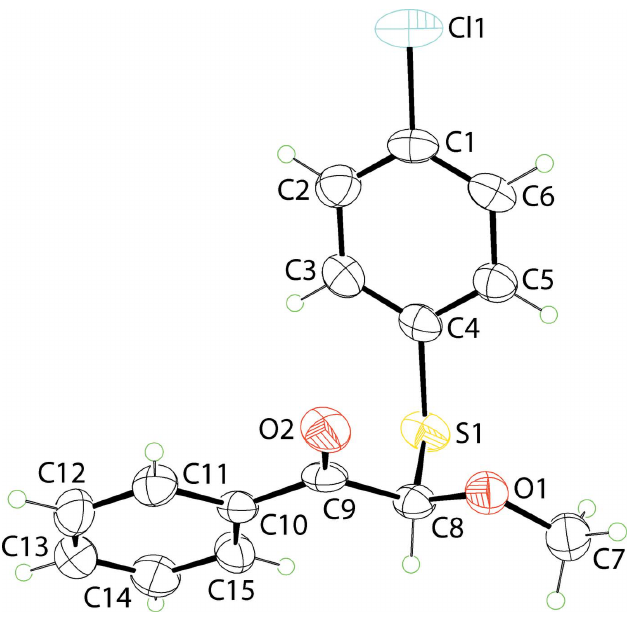
Figure 1 The molecular structure of (I), showing the atom-labelling scheme and displacement ellipsoids at the 35% probability level.